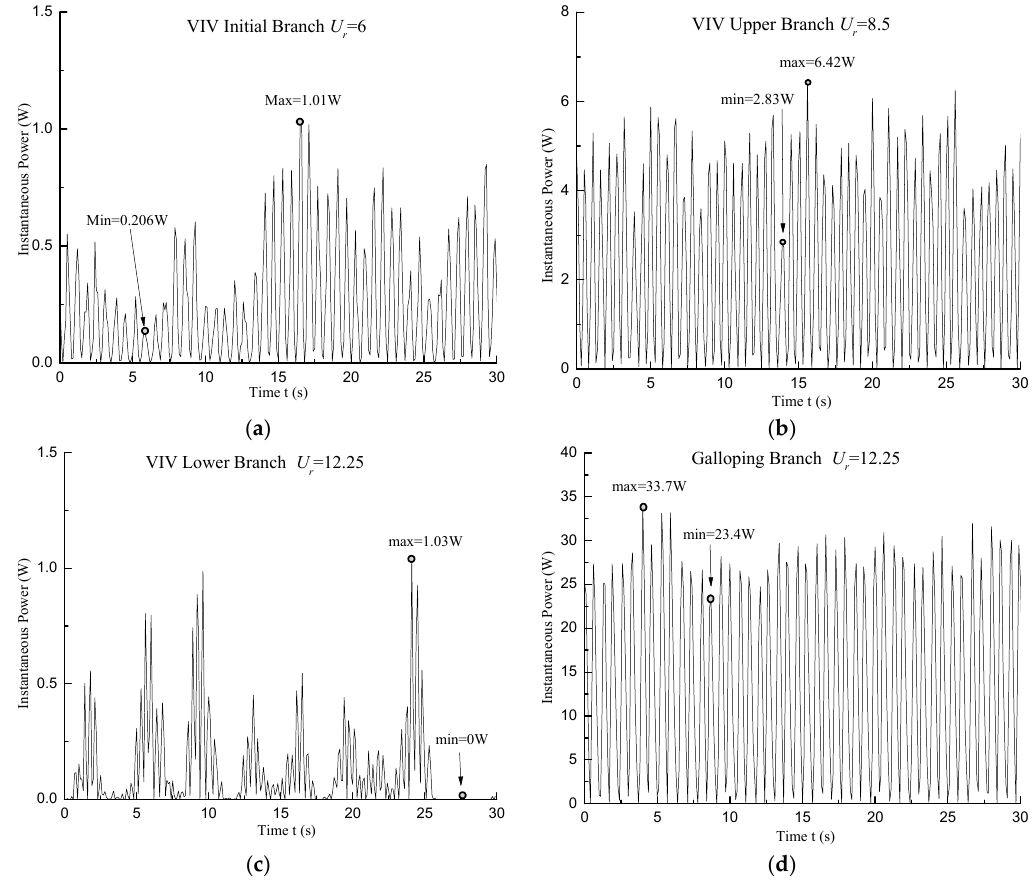
Figure 17. Power generation instantaneous power time-history curves of the T-section prism with R L = 16 Ω : ( a ) VIV initial branch; ( b ) VIV upper branch; ( c ) VIV lower branch; ( d ) galloping branch. Figure 16a,c show that the instantaneous voltage peaks fluctuated greatly when the prism underwent the VIV initial branch ( V max = 4.04 V, V min = 1.81 V) and the VIV lower branch ( V max = 4.07 V, V min = 0 V). This led directly to the instability of the instantaneous power of the VIV initial branch ( P max = 1.01 W, P min = 0.206 W) and the VIV lower branch ( P max = 1.03 W, P min = 0 W), as shown in Figure 17a,c. Additionally, the instantaneous voltages of the VIV initial branch and the VIV lower branch were small, so that the powers were not as high as the instantaneous active power in the VIV upper branch ( P max = 6.42 W, P min = 2.83 W) and in the galloping branch ( P max = 33.7 W, P min = 23.4 W), as